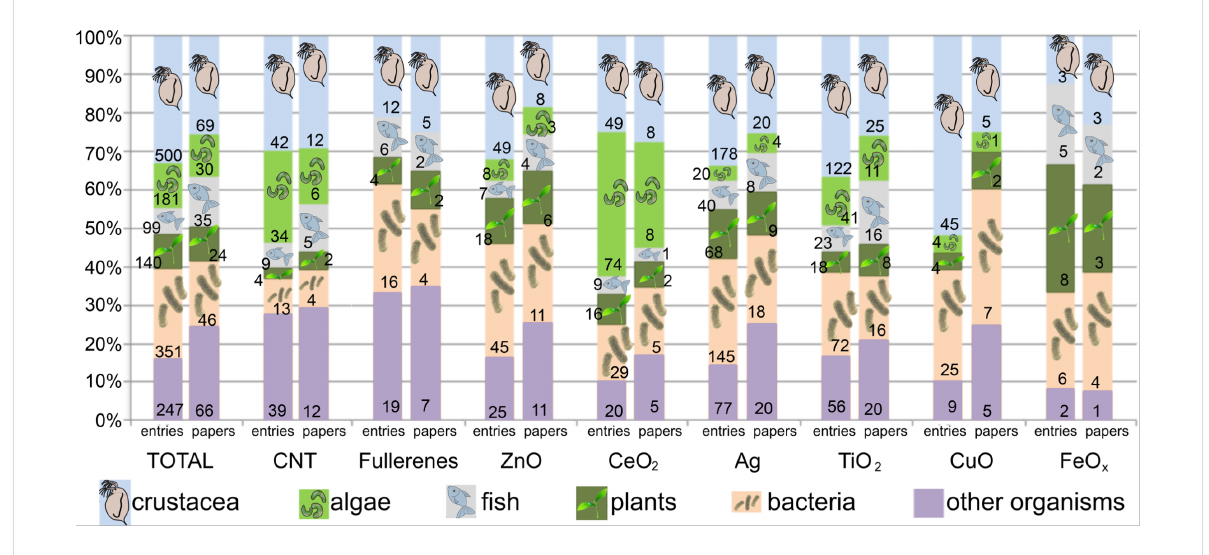
Figure 5: Types of test organisms used for evaluation of biological effects of selected ENMs in NanoE-Tox database. For each ENM, the left column represents the number of entries and right column represents the number of respective publications in the database. The database entries were selected based on bibliometric data search in Thomson Reuters WoS using the keywords as indicated in Table 1 as of January 6, 2015. The number of papers and entries for different ENMs is also presented in Figure